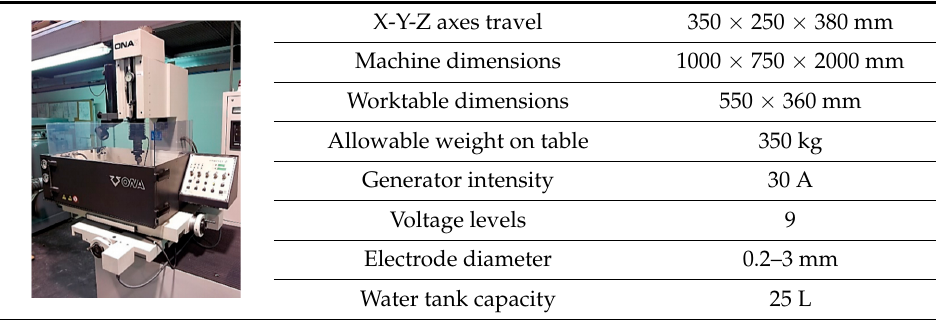
Table 2. ONA© Compact 2 characteristics.